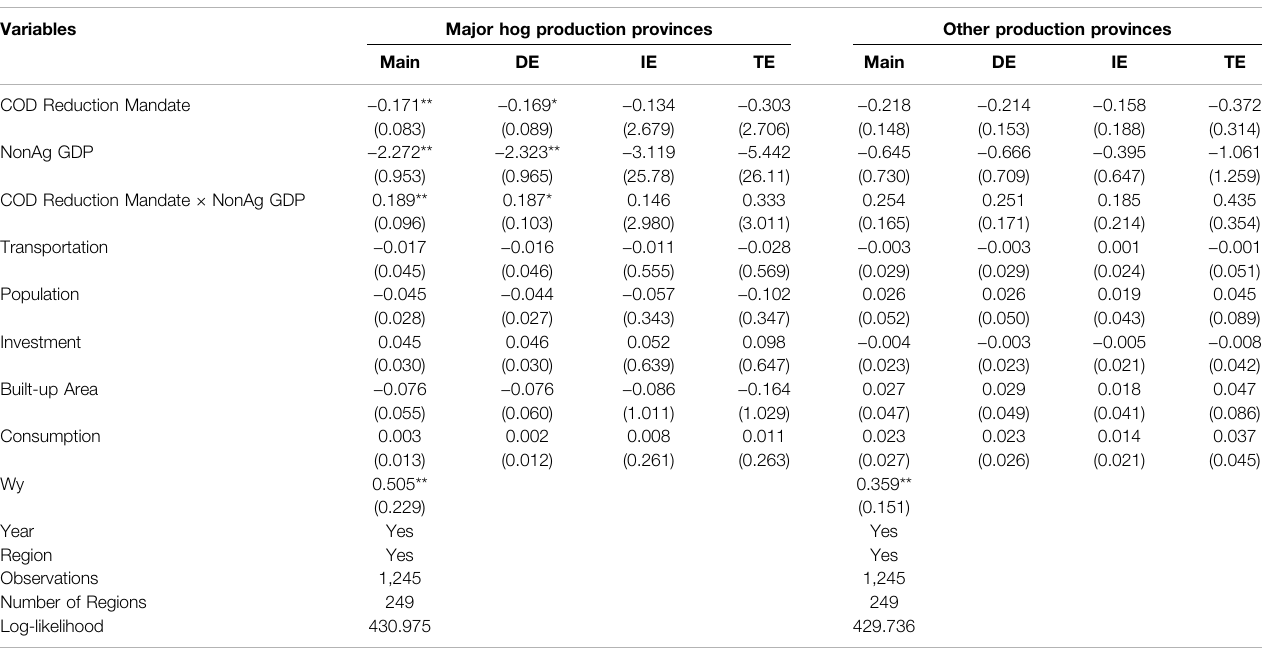
TABLE 5 | Heterogeneity test of 12th Five-Year